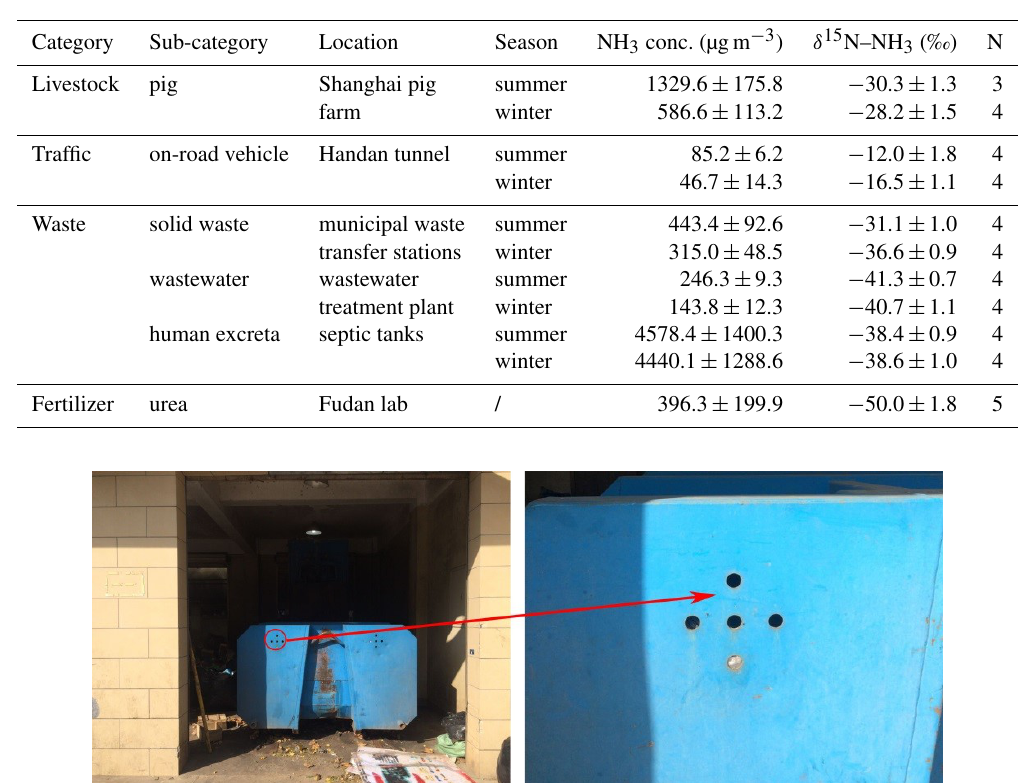
Figure 2. Field photos of a solid waste container in the solid waste transfer station we used for source sampling at Fudan University. Before sampling, an Ogawa passive sampler for NH 3 is attached on a plastic strip (1.5m in length). The sampler is fitted into the container through the holes (shown on the right